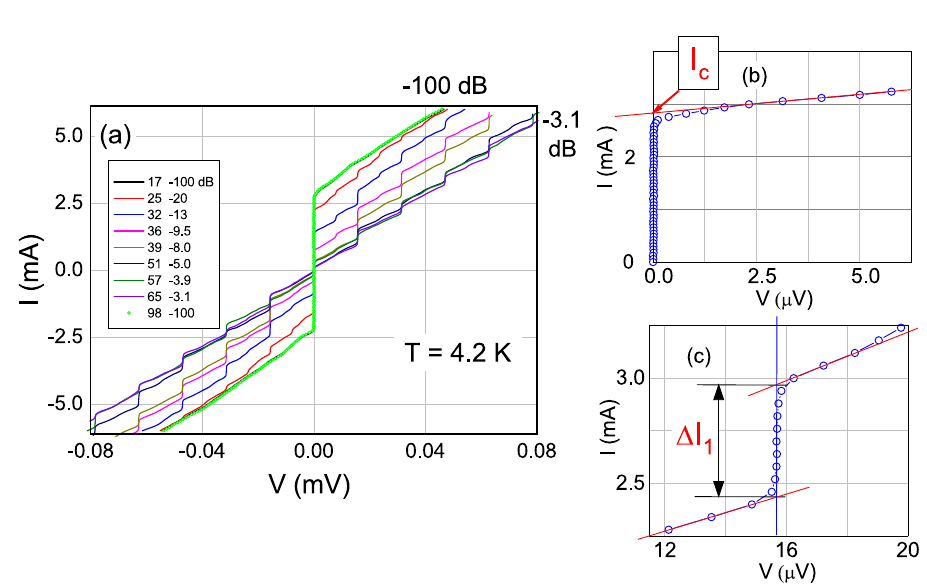
Figure 4. ( a ) Some examples of current-voltage characteristics of the Pb 0.6 In 0.4 / Ba 0.6 K 0.4 (FeAs) 2 Josephson point-contact No. 1 recorded at f = 7.6GHz and different levels of microwave power. The legend reports the numbers of the I − V characteristics and the relevant attenuation of the microwave power in decibels. Panels ( b ) and ( c ) show the method for measuring the critical current and the amplitude of the current steps. ( b ) Initial part of I − V curve 17. The thin straight line shows the extrapolation of the initial part of the I − V characteristic made for determining the critical current I c of the contact I c = 2.82mA . ( c ) Part of curve 32. The amplitude of the step was determined by the points of intersection of the vertical line passing through the center of the step with the lines extrapolating the I − V